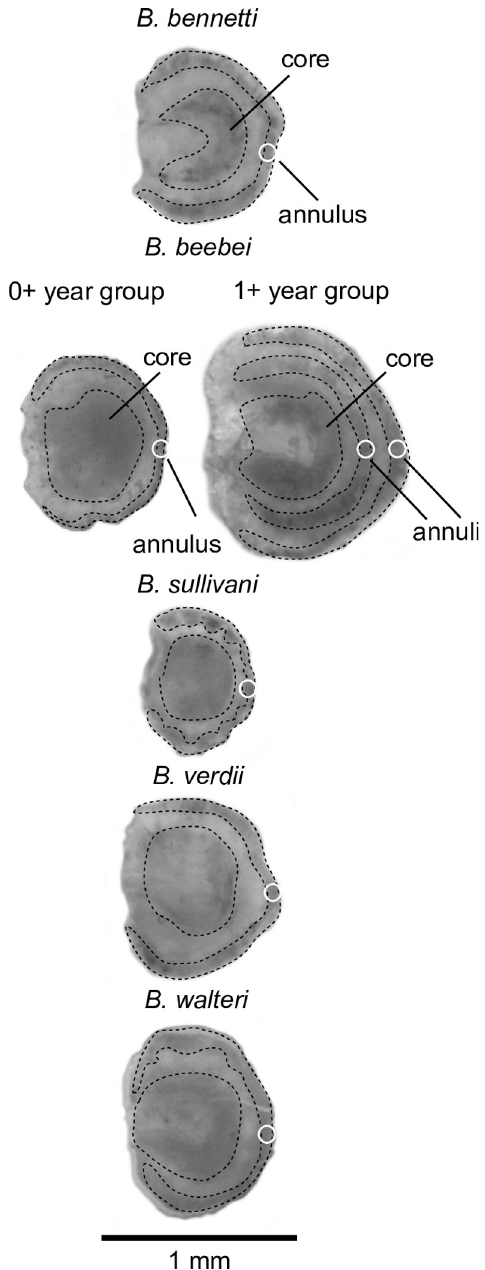
Fig 6. Sagittal otolith preparations for representative Stage 4 individuals of five species of Brachyhypopomus . Dotted lines are superimposed to highlight the positions of the otolith core and dark annuli. Note the single dark annulus in species with one-year semelparous (annual) lifespans: B . bennetti , B . sullivani , B . verdii , B . walteri . Note the single dark annulus in the 0+ year group of the iteroparous species B . beebei , but two dark annuli in the 1+ year